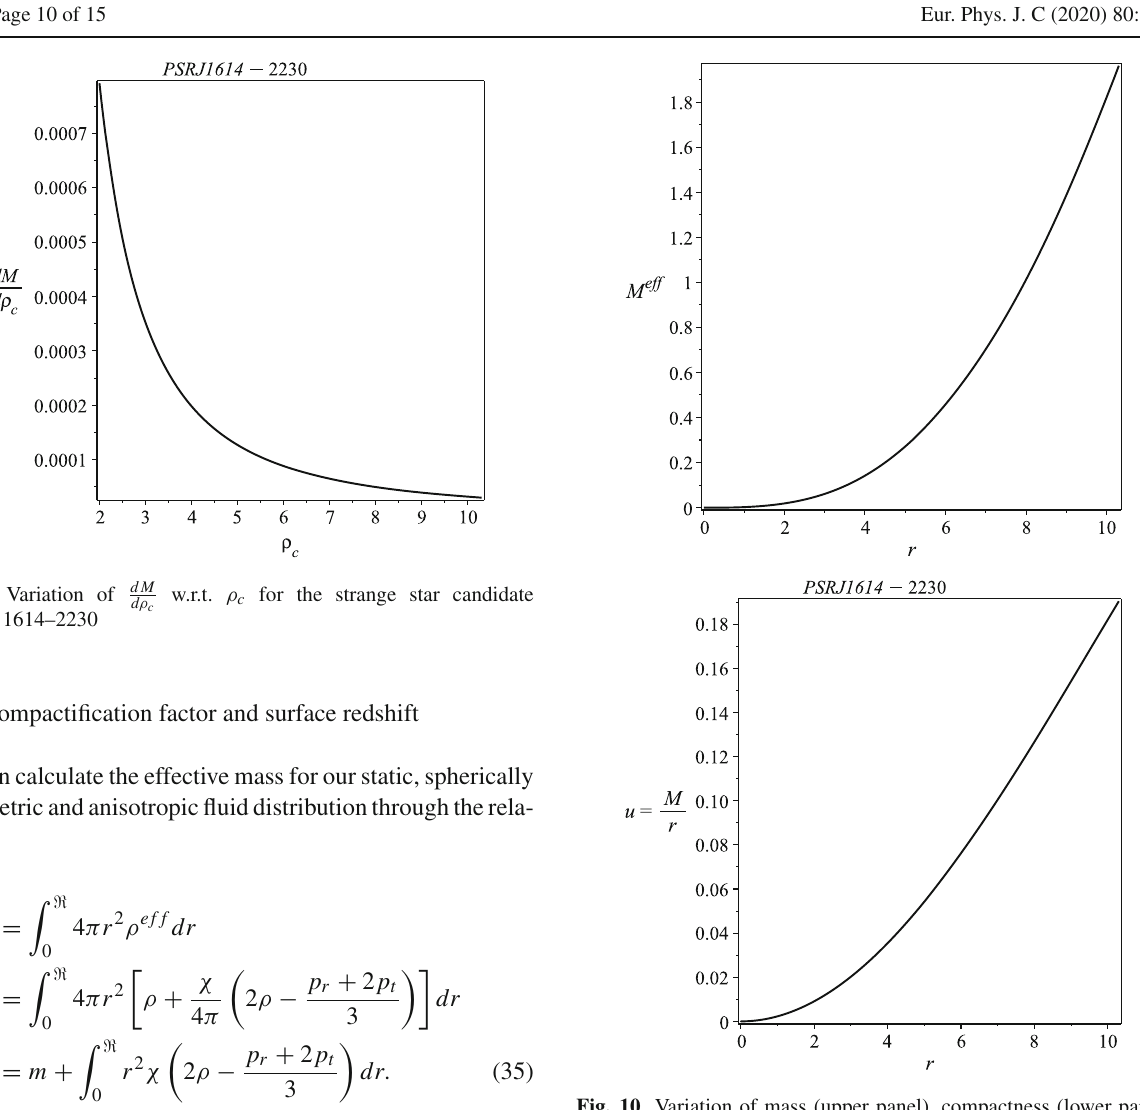
Fig. 10 Variation of mass (upper panel), compactness (lower panel) w.r.t. the radial coordinate r for the strange star candidate PSRJ 1614–